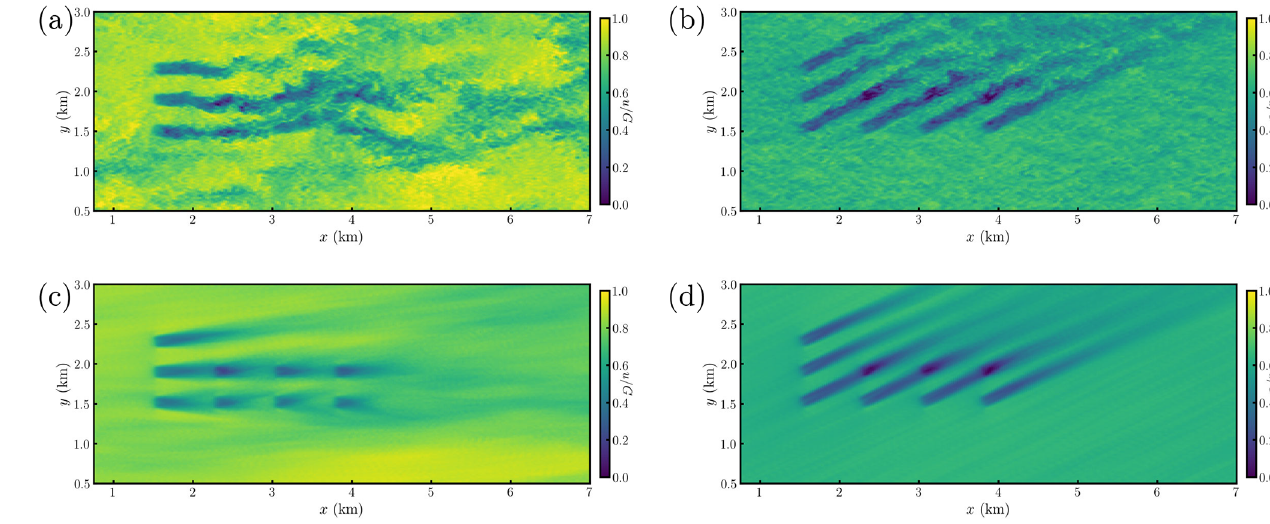
Figure B2. Zoomed-in hub-height streamwise velocity during (a, c) unstable and (b, d) stable ABL conditions for the baseline yaw-aligned control case. Instantaneous snapshots are shown in (a) and (b) , and 10min moving averaged flow fields are shown in (c) and (d) . The streamwise velocity in the full domain is shown in Fig.